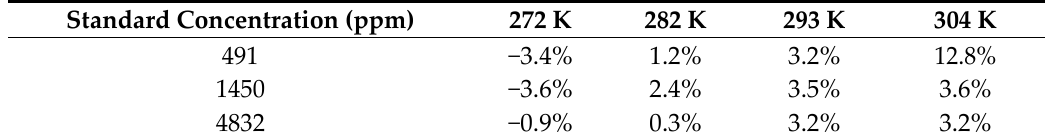
Table 2. Measurement results of CO 2 concentrations at random temperatures and standard CO 2